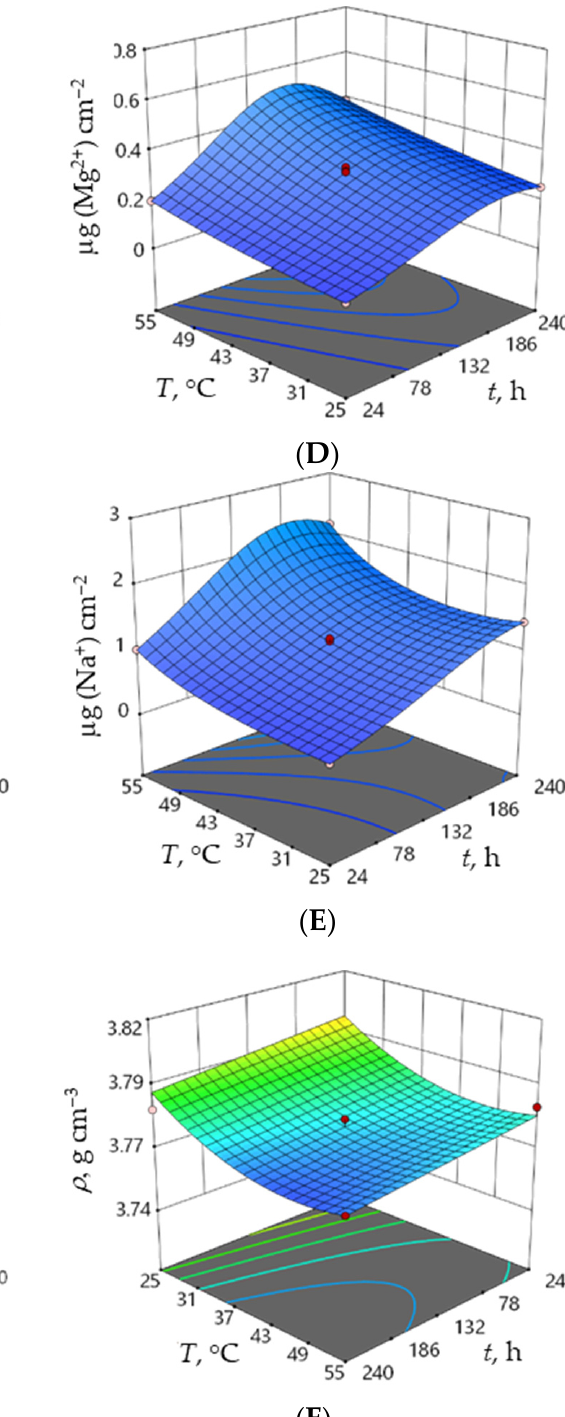
Figure 5. Normal plot of residuals: ( A ) amounts of aluminium ions, and ( B ) density.